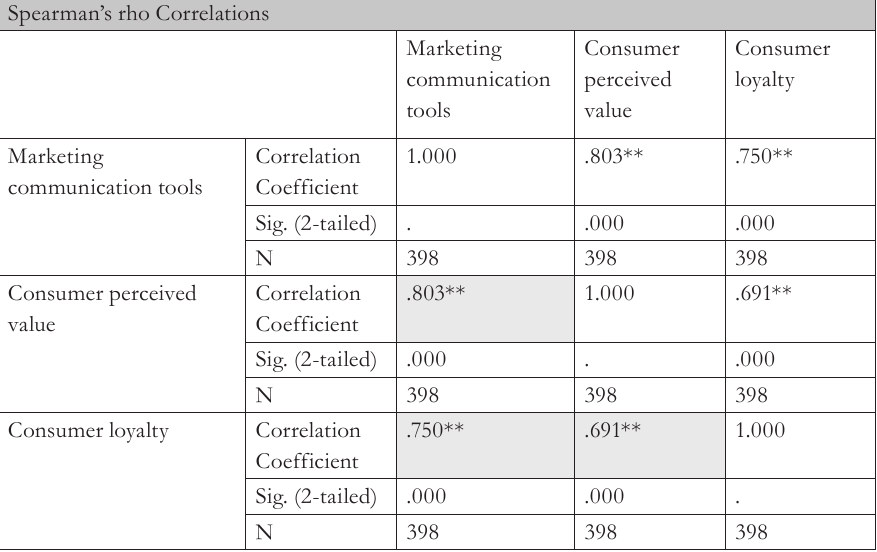
Tab. 2 – Correlation coefficients between variables. Source: own research Spearman’s rho Correlations